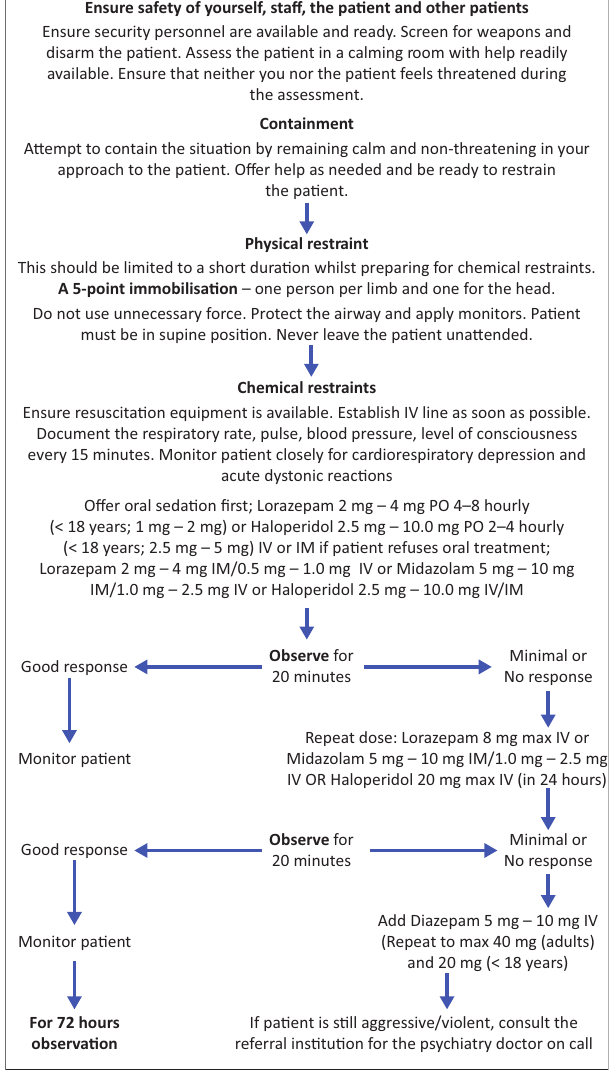
FIGURE 1: Algorithm for managing aggressive and violent patient in a district hospital.